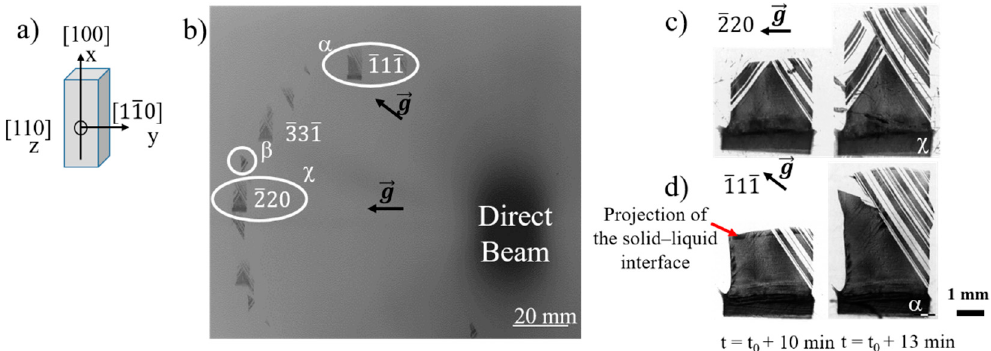
Figure 2. X-ray diffraction images (topographs) recorded during solidification (applied temperature gradient: 30 K/cm and cooling rate of -1 K/min applied on both heaters at t 0 ) from a FZ seed. ( a ) Crystallographic orientation of the seed. ( b ) Laue pattern recorded at the end of solidification showing the diffraction spots in the field of view. Images of the ( c ) 1(cid:3364)11(cid:3364) and ( d ) 2(cid:3364)20 topographs recorded at two instants during solidification.